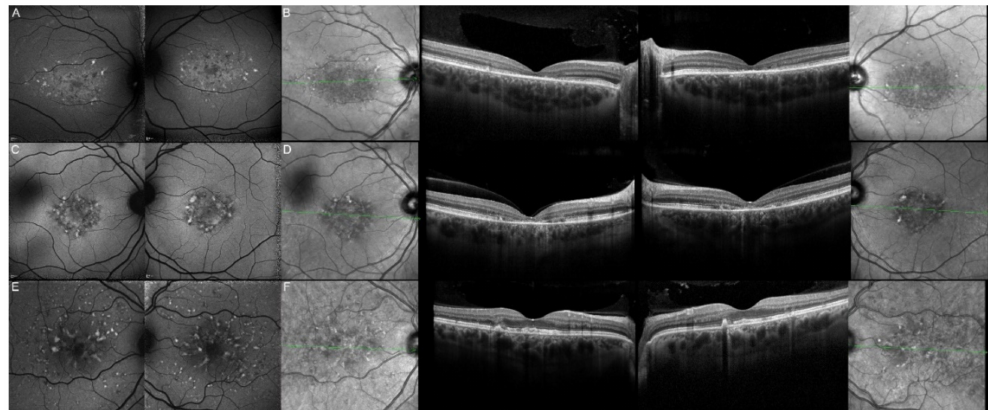
Figure 13. “Flecks” clinical phenotype. FAF ( A ) and OCT ( B ) imaging of STGD1 patient 3/II.2 compound heterozygous for the c.4124C>A p.(Ala1375Glu) and c.5377G>A p.(Val1793Met) ABCA4 variants. FAF ( C ) and OCT ( D ) imaging of STGD3 patient 14/II.4 harboring the pathogenic c.810C>G p.(Tyr270*) ELOVL4 variant. FAF ( E ) and OCT ( F ) imaging of patient 17/II.1 affected by c.422A>G p.(Tyr141Cys) PRPH2 -associated autosomal dominant Stargardt-like macular dystrophy.